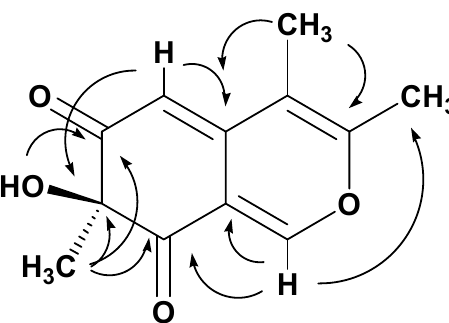
Figure 2. HMBC correlation of chlamyphilone.